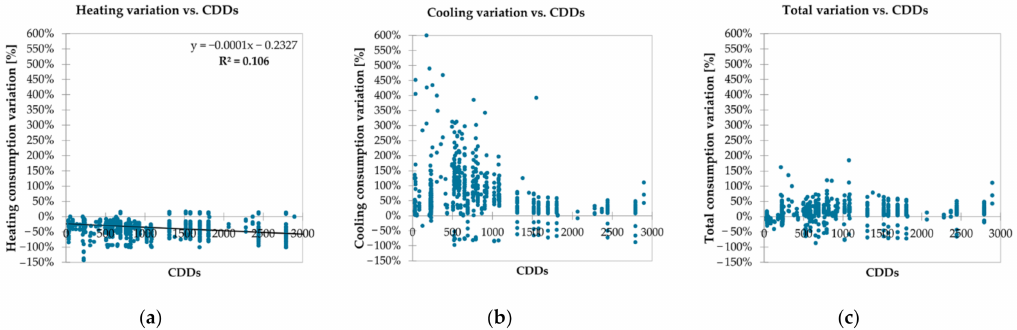
Figure 6. Relationship between C DDs and: ( a ) heating consumption variation; ( b ) cooling consump- tion variation; ( c ) total consumption